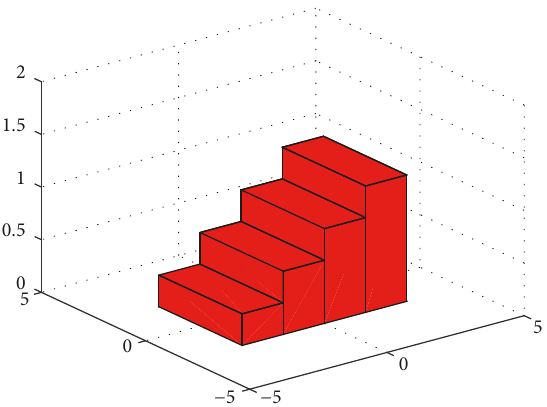
Figure 10: Example of environment map for